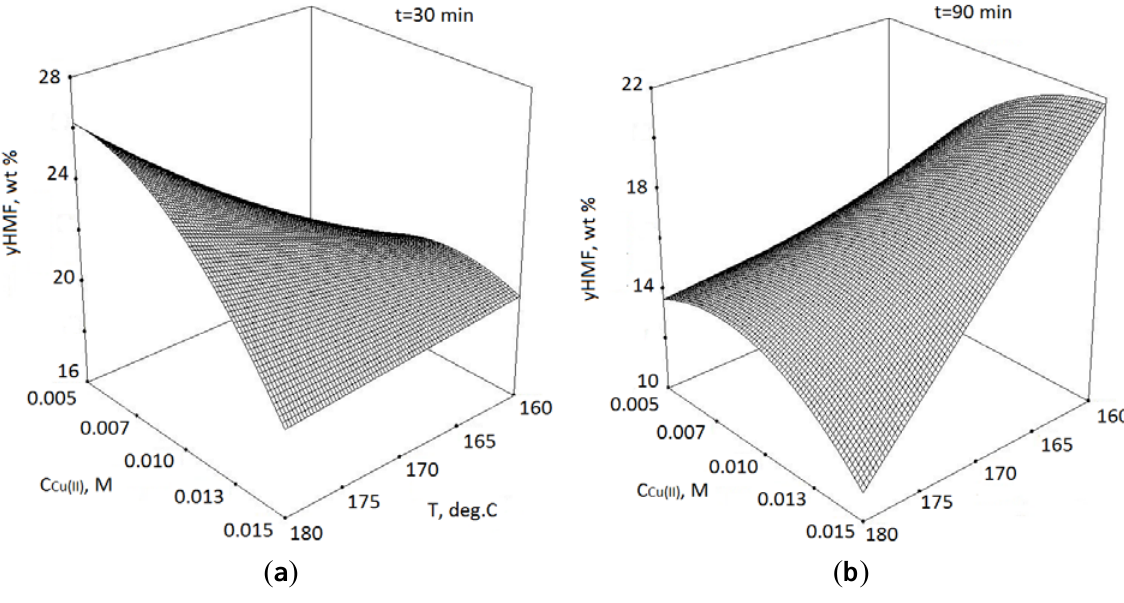
Figure 11. Modelled HMF yield versus temperature and inulin intake at ( a ) 30 min and ( b ) 90 min batch